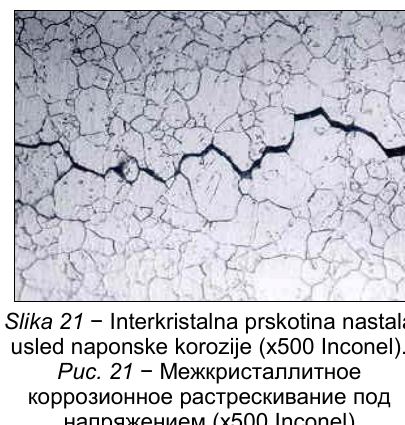
Рис . 20 − Трещина в результате коррозионного напряжения . Острая трещина с ровными краями . Транскристаллитная трещина Figure 20 − Crack as a result of stress corrosion. The crack is sharp and straight – transgranular crack